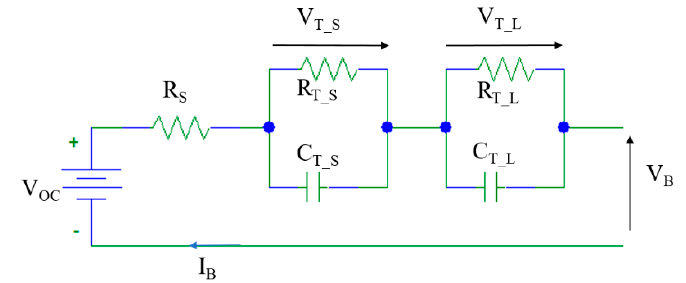
Figure 6. Impedance model of the battery.